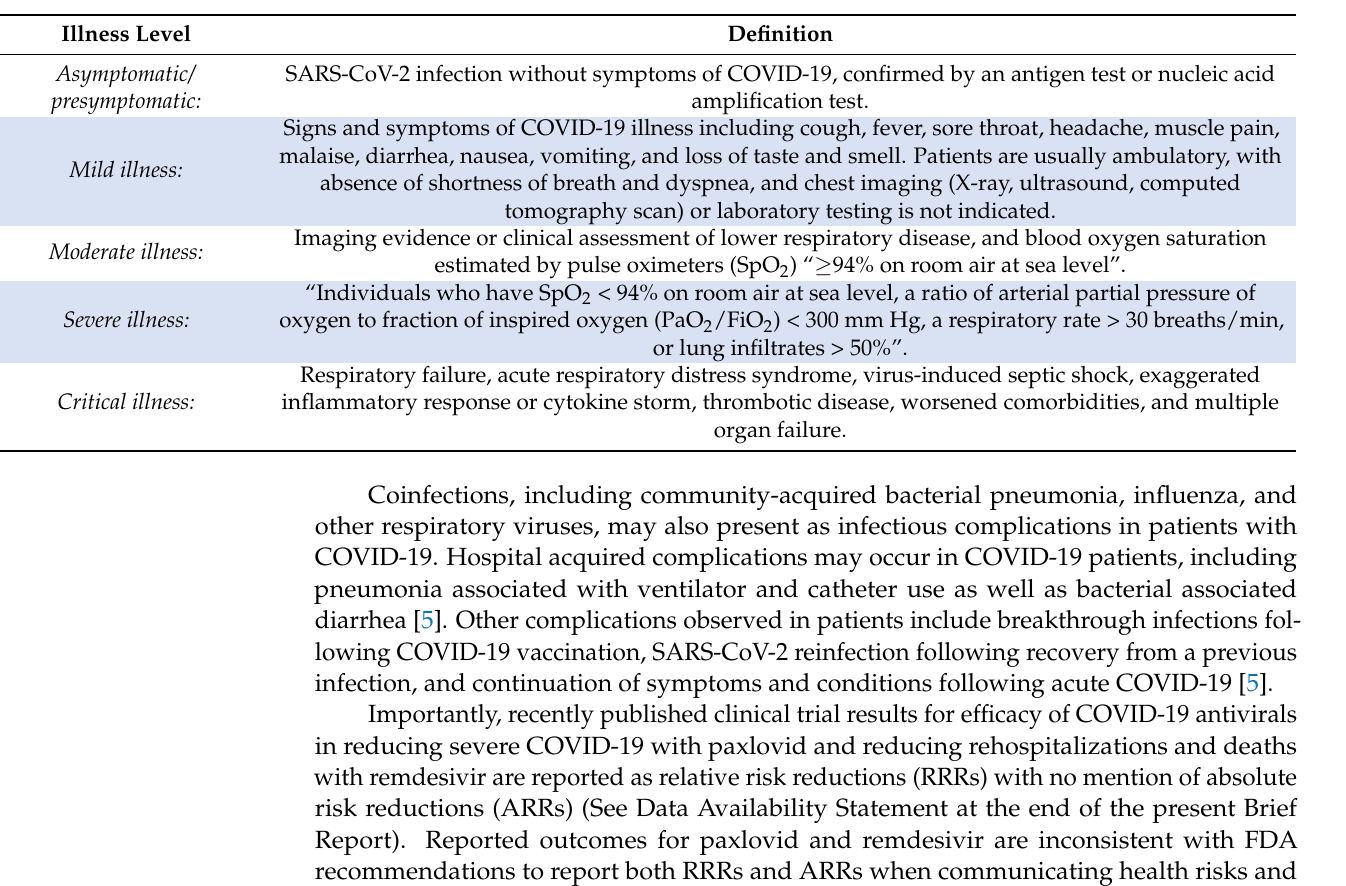
Table 1. COVID-19 illness severity